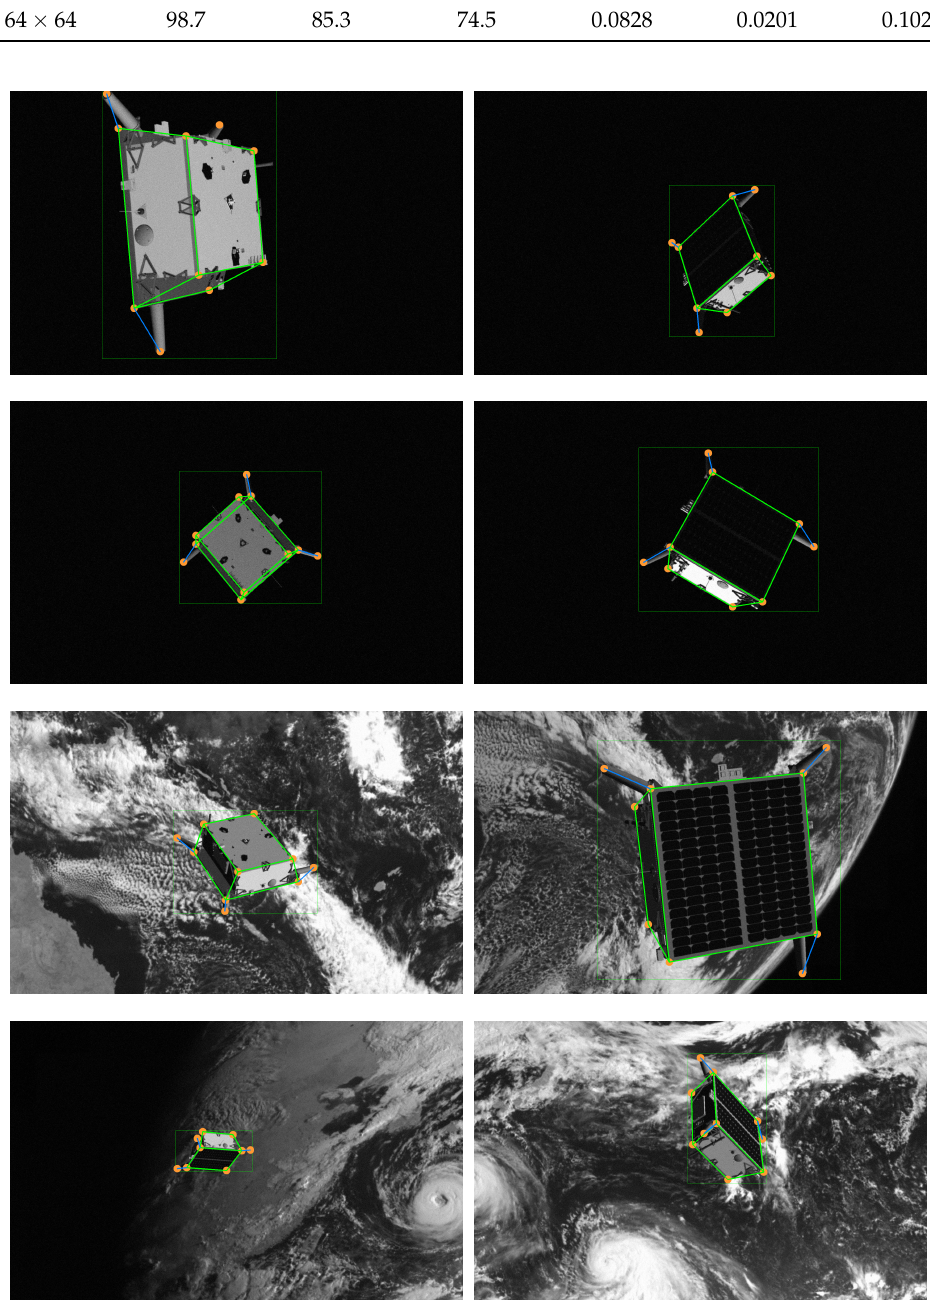
Figure 8. Qualitative results for the proposed space target landmark regression network using Gaussian kernel-based 1D landmark representations at the input resolution of 512 ×